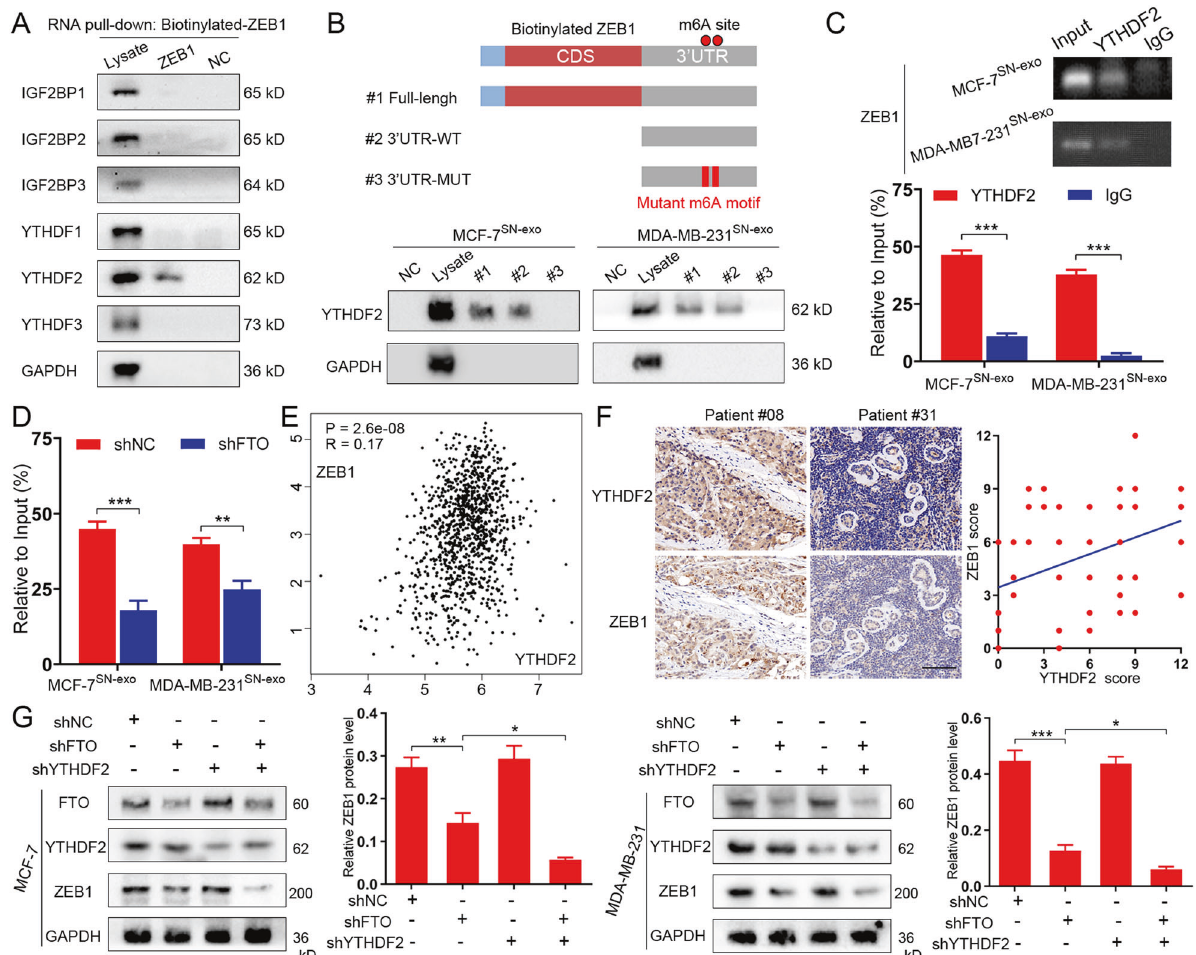
Fig. 6 YTHDF2 is essential for the posttranscriptional regulation of ZEB1 by piR-17550/FTO signaling. A RNA pulldown was performed with biotinylated ZEB1. Immunoblotting of IGF2BP family and YTH family m6A readers in cell lysate, biotinylated full-length ZEB1 and beads only (NC) in MCF-7 SN-exo cells. B Immunoblotting of ZEB1 full length (#1), ZEB1 3 ’ UTR region (#2), 3 ’ UTR m6A motif mutant ZEB1 (#3), lysate (Ly) and beads only (NC) by RNA pulldown assay in MCF-7 SN-exo and MDA-MB-231 SN-exo cells. C RIP assays showing the direct binding between YTHDF2 protein and ZEB1 mRNA in HCT116 and DLD1 cells. Agarose electrophoresis (up) and qPCR analysis (down). D RIPassays demonstrating the enrichment of YTHDF2 protein bound ZEB1 mRNA in shNC versus shFTO MCF-7 SN-exo and MDA-MB-231 SN-exo cells. E The correlation between YTHDF2 and ZEB1 in breast cancer was analyzed in TCGA. F Expression correlation of YTHDF2 and ZEB1 was analyzed in breast cancer patients ( n = 82) using IHC. Scare bars, 100 μ m. G Immunoblotting of YTHDF2, FTO and ZEB1 protein levels in MCF-7 SN-exo and MDA-MB-231 SN-exo cells with shNC, FTO knockdown only (shFTO#1), YTHDF2 knockdown only (shYTHDF2) and both FTO and YTHDF2 knockdown (shFTO + shYTHDF2). Data represent the mean ± SD of at least three independent experiments. * P < 0.05, ** P < 0.01, *** P < 0.001, ns, not signi fi